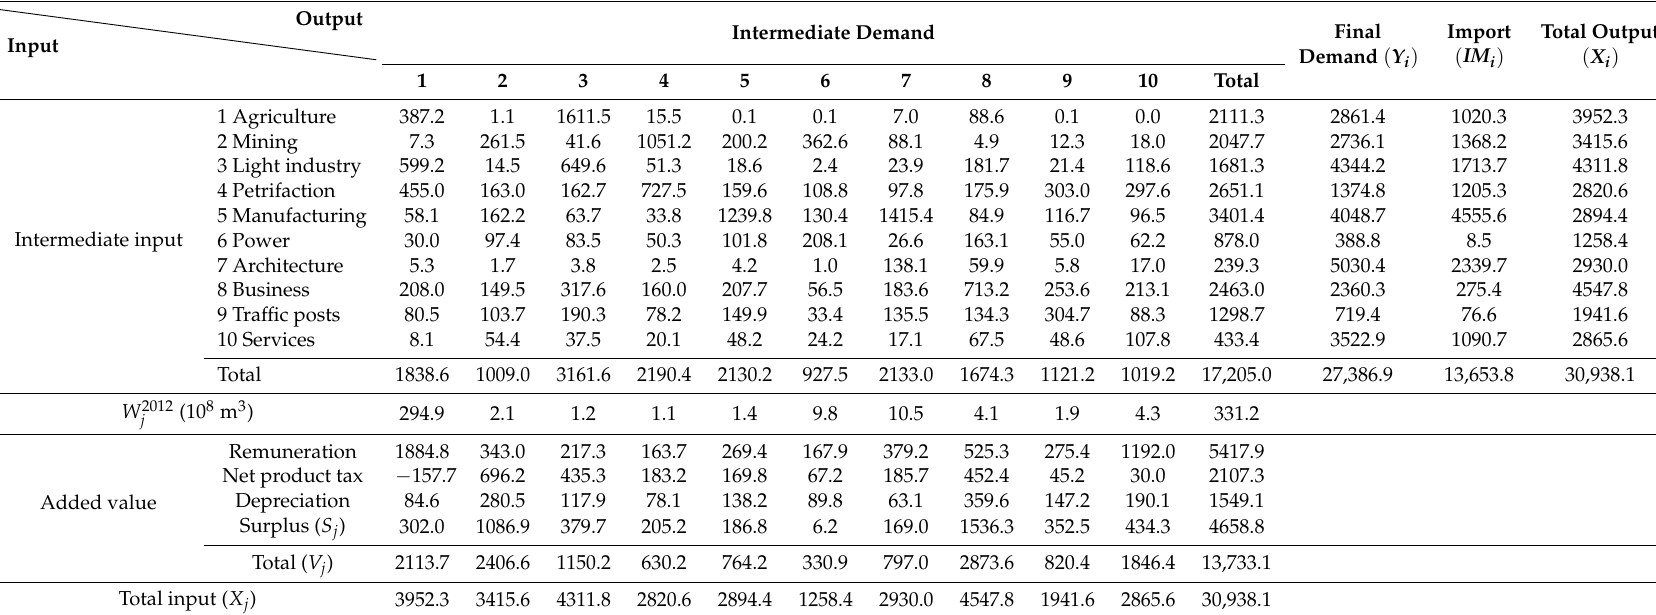
Table 1. Water resource input–output table of Heilongjiang Province in 2012 (in 10 8